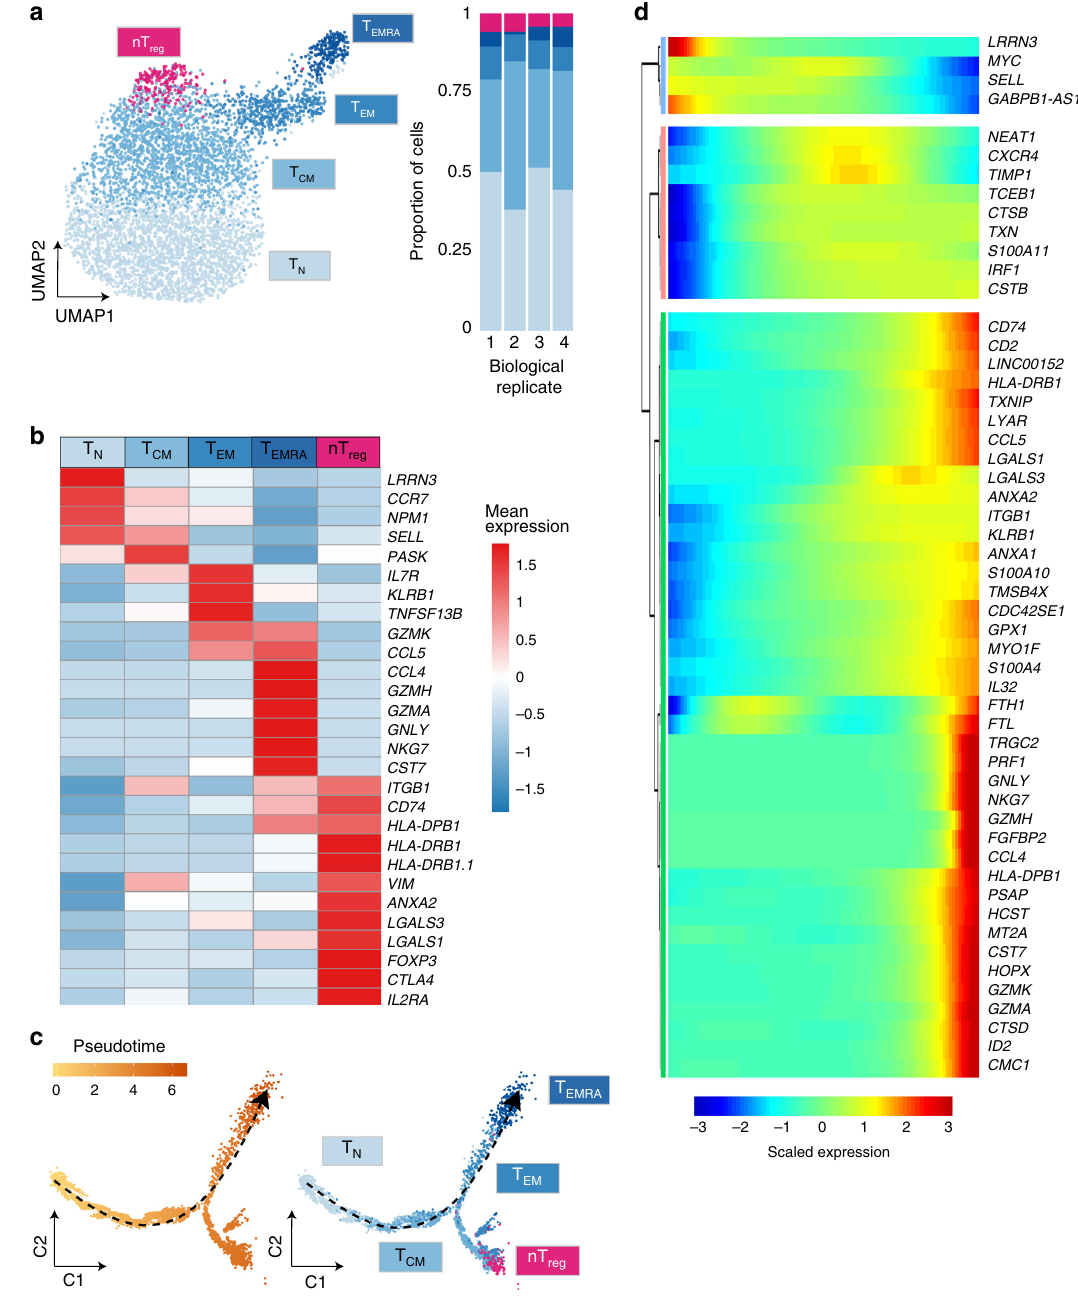
Fig. 3 Effectorness gradient in resting CD4 + T cells. a UMAP of single-cell RNA-seq data from resting T cells. Colors represent cells in the fi ve clusters de fi ned using top variable genes and unsupervised clustering. Bar plots represent the proportion of cells assigned to different clusters in each biological replicate. b Gene markers of each cell cluster (Wilcoxon rank sum test) combined with well known markers from the literature. Colors encode the mean expression of each gene in each cluster. c Branched pseudotime trajectory, each cell is colored by its pseudotime value (left panel) or its cluster label (right panel), as determined in a . d Heatmap of genes variable along the pseudotime trajectory (from Monocle). The X axis represents cells ordered by pseudotime (from left to right) and different colors correspond to the scaled (Z-scored) expression of each gene in each cell. Source data are provided as a Source Data fi